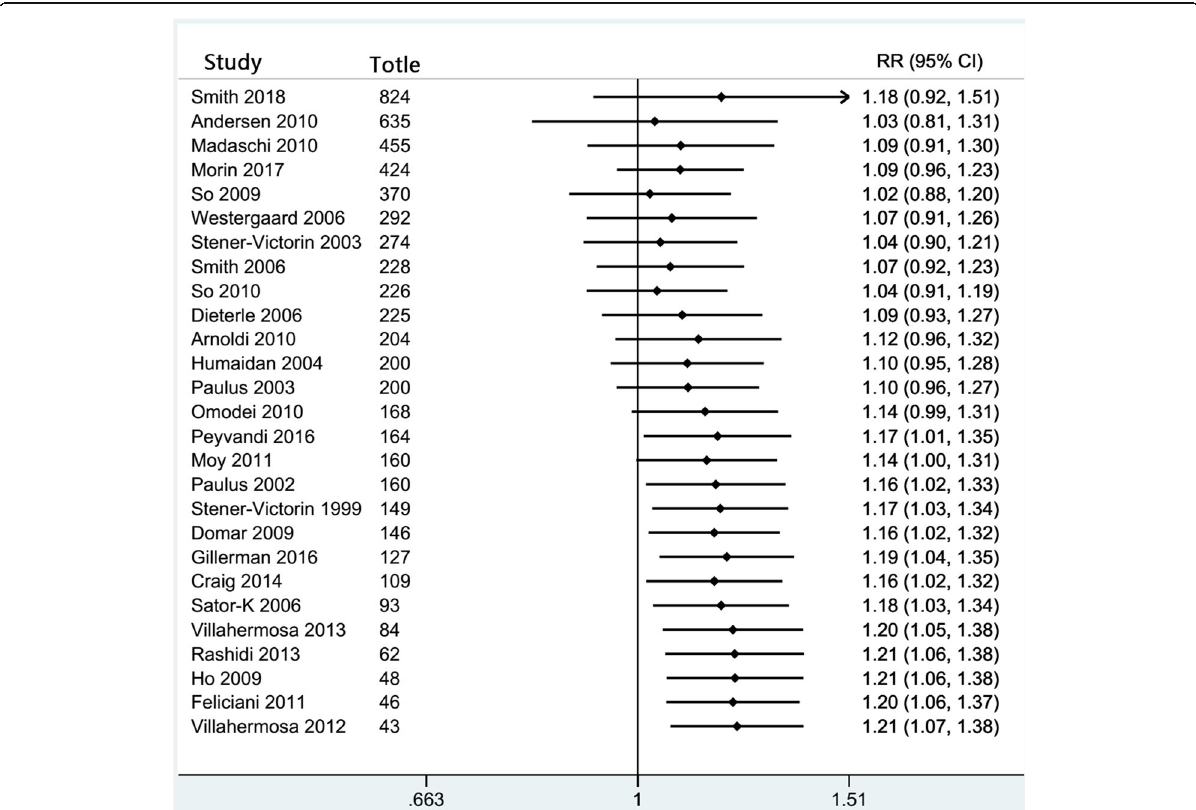
Fig. 6 The result of cumulative meta-analysis based on sample